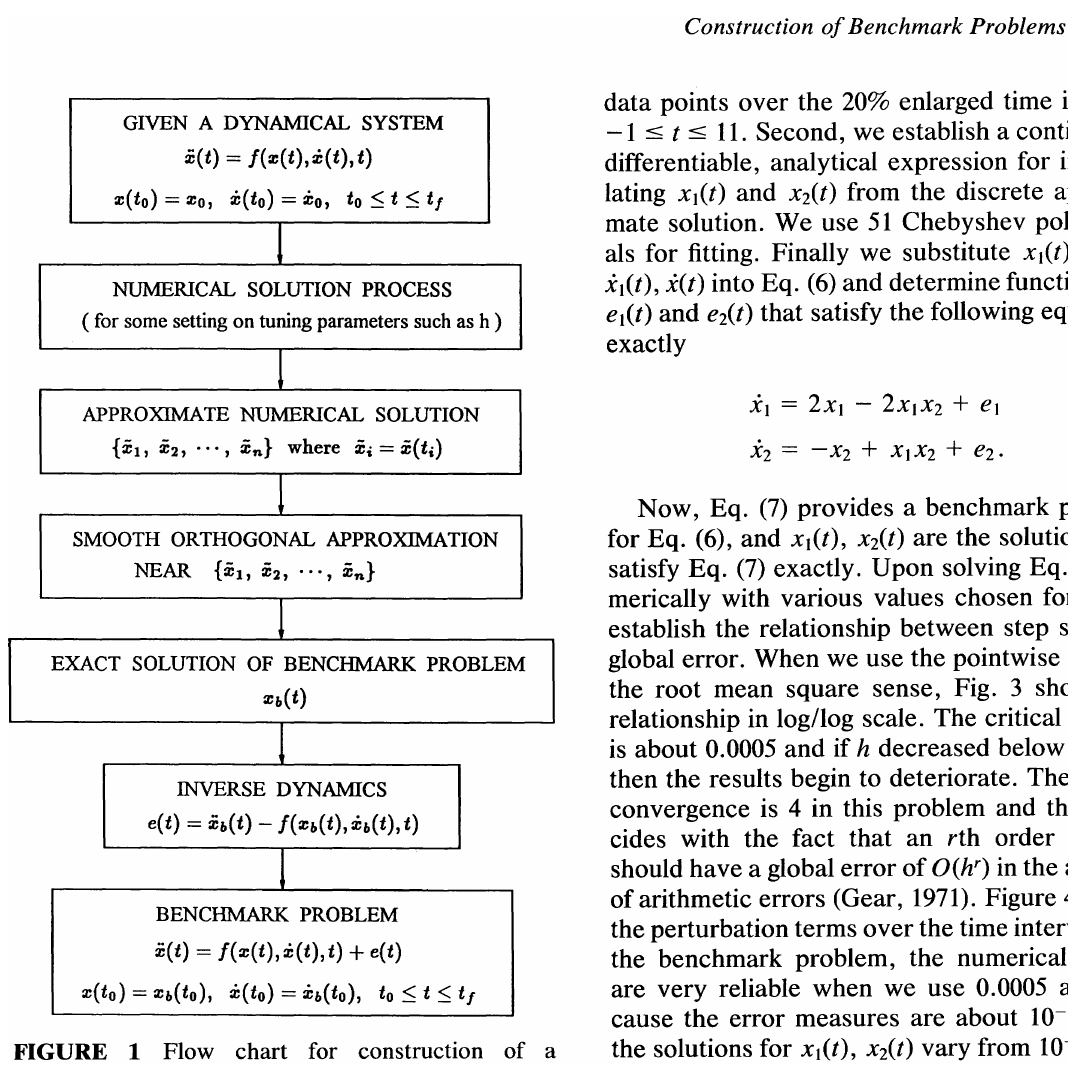
FIGURE 1 Flow chart for construction of a benchmark